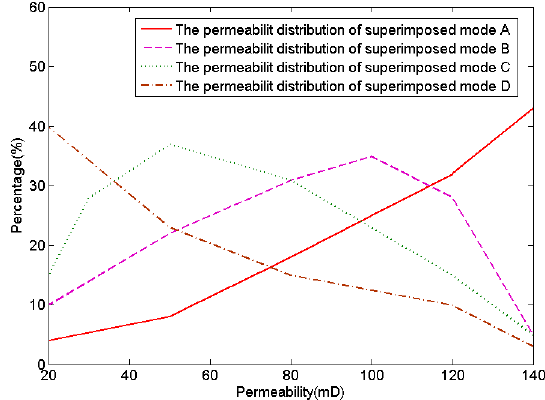
Figure 2. Schematic of permeability distribution of different superimposed modes.